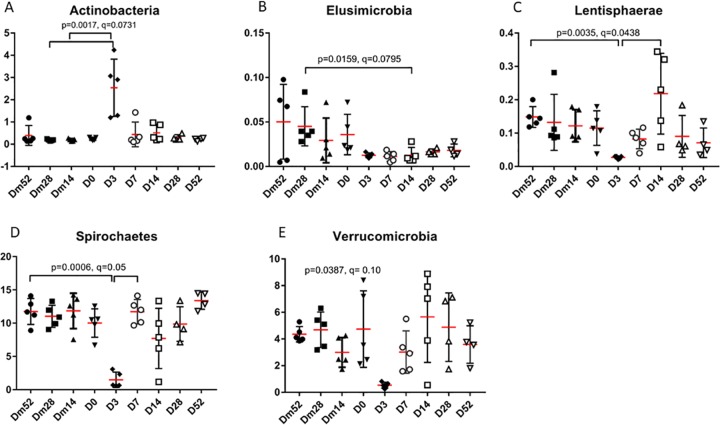
The median abundance (%) of significantly different fecal phyla across study days.(A) Actinobacteria. (B) Elusimicrobia. (C) Lentisphearae. (D) Spirochaetes. (E) Verrucomicrobmia.